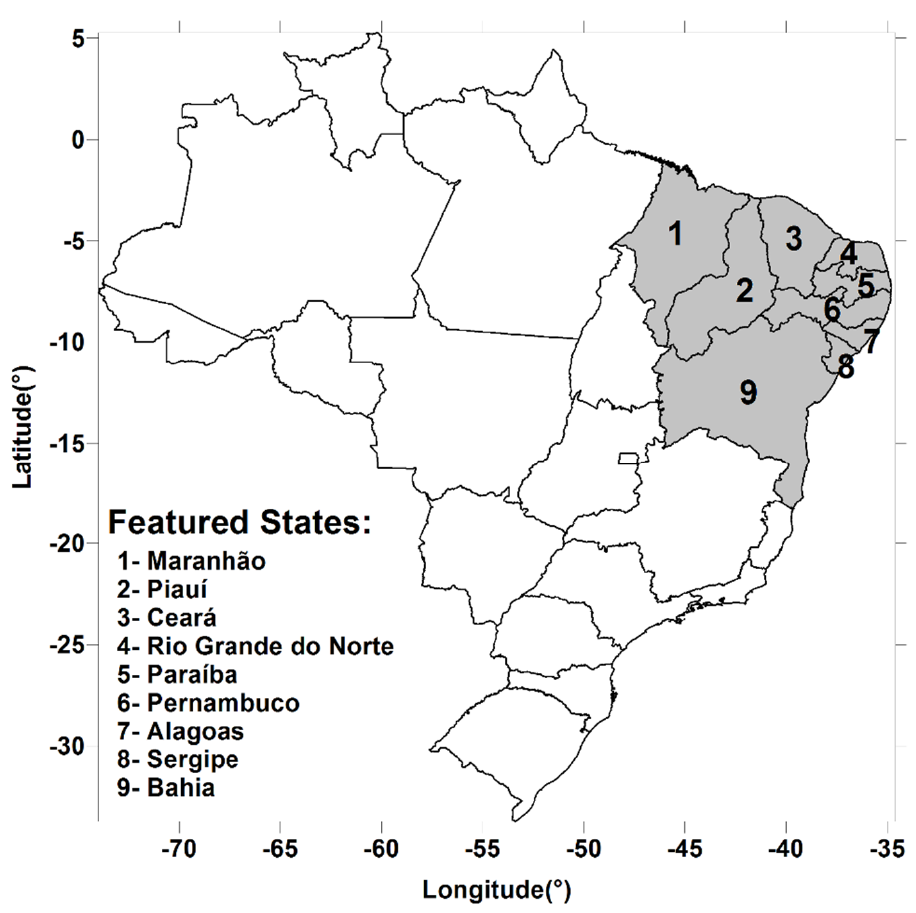
Figure 1. Map of Brazil highlighting the Northeast region in gray, showing its labeled and identified states.